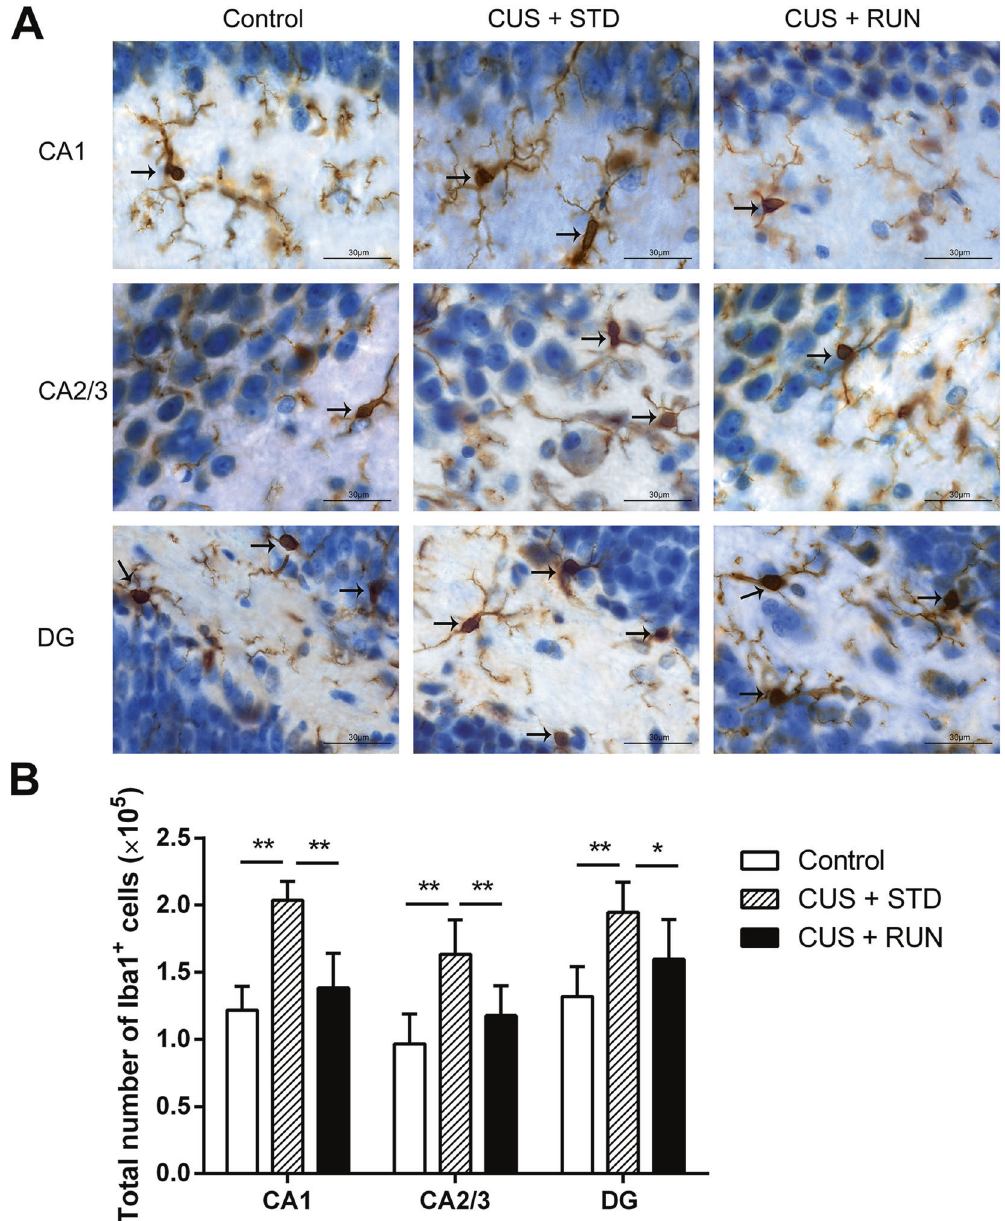
Fig. 3 The effects of running exercise on the numbers of microglia in sub fi elds of the hippocampus in CUS-exposed rats. A Representative images of immunohistochemical staining of Iba1 in each subregion of the hippocampus (×100 oil). Scale bar = 30 μ m. B Quantitative analyses comparing the numbers of Iba1 + cells in the CA1, CA2/3, and DG areas among the control group, the CUS + STD group, and the CUS + RUN group. The data are expressed as the mean ± SD ( n = 5 per group). * p < 0.05 and ** p < 0.01. CUS + STD CUS + standard, CUS + RUN CUS +